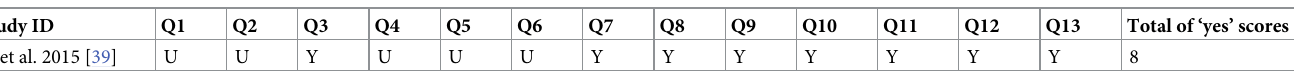
Table 2. Methodological quality of randomized controlled trails.